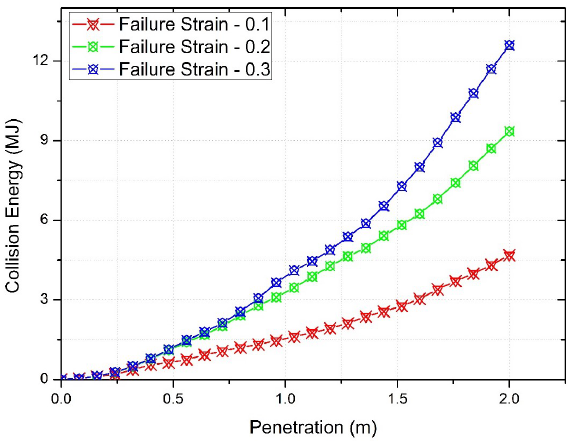
Figure 8: Effect of failure strain into energy